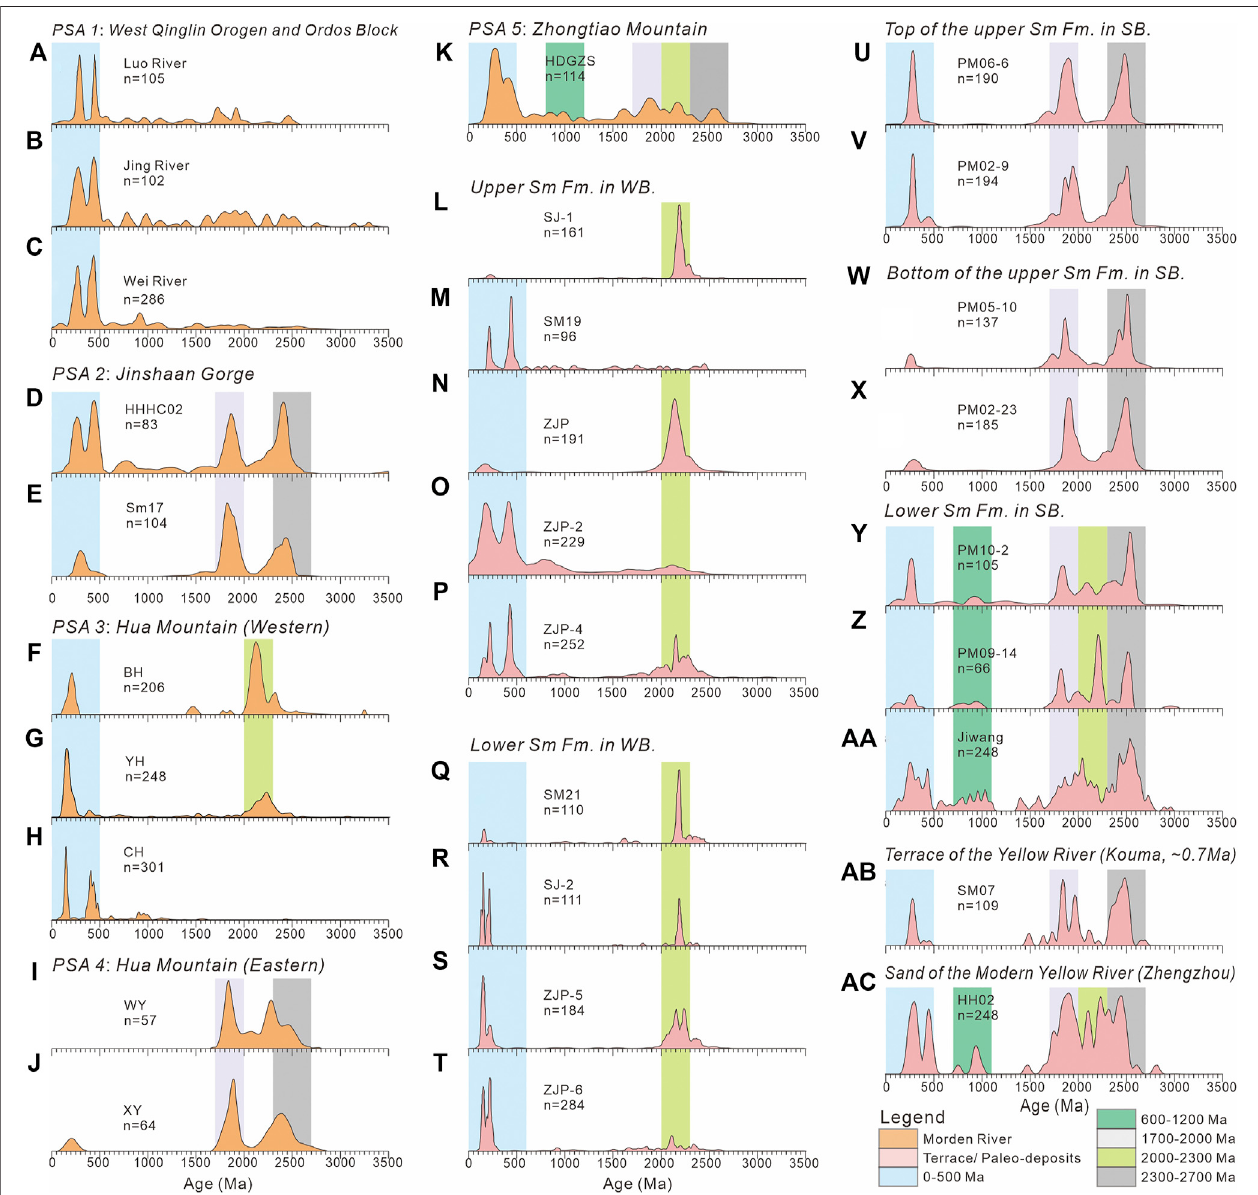
FIGURE 3 | Zircon U-Pb ages of the Sm Fm. and potential source areas of the region. The bands show different age ranges of zircon grains indicated by colors de fi ned in the lower panel. A – C, D – E, F – H, I – J, and K show the sediments from potential source areas of western Qinling Orogen and Ordos, Jinshaan Gorge, the western part of Hua Mountain, the eastern part of Hua Mountain, and Zhongtiao Mountain, respectively. L – M and N – T show the sediments from the upper and lower parts ofthe SmFm.inWeihe Basin. U-V,W-X, andY-AA showthesediments fromthe upper, middle, and lower parts oftheSmFm.in theSanmenxia Basin. AB and AC show the sediments from the terrace of the Yellow River and modern Yellow River,